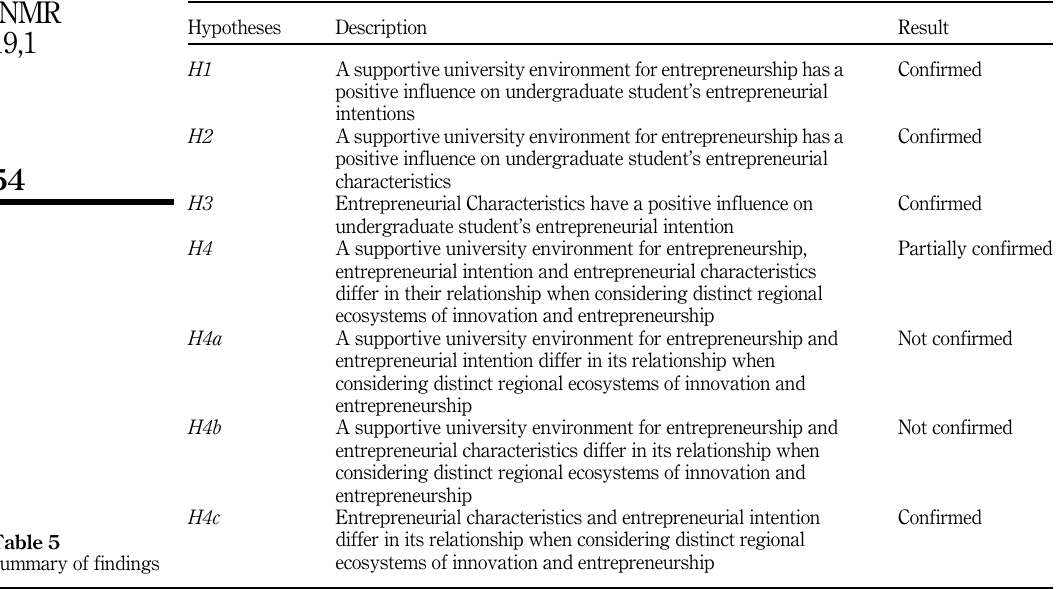
Table 5 Summary of